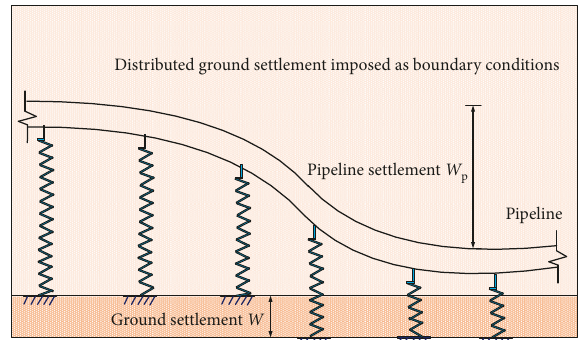
Figure 2: Finite-element analysis of pipeline responses to excavation-induced ground movement.